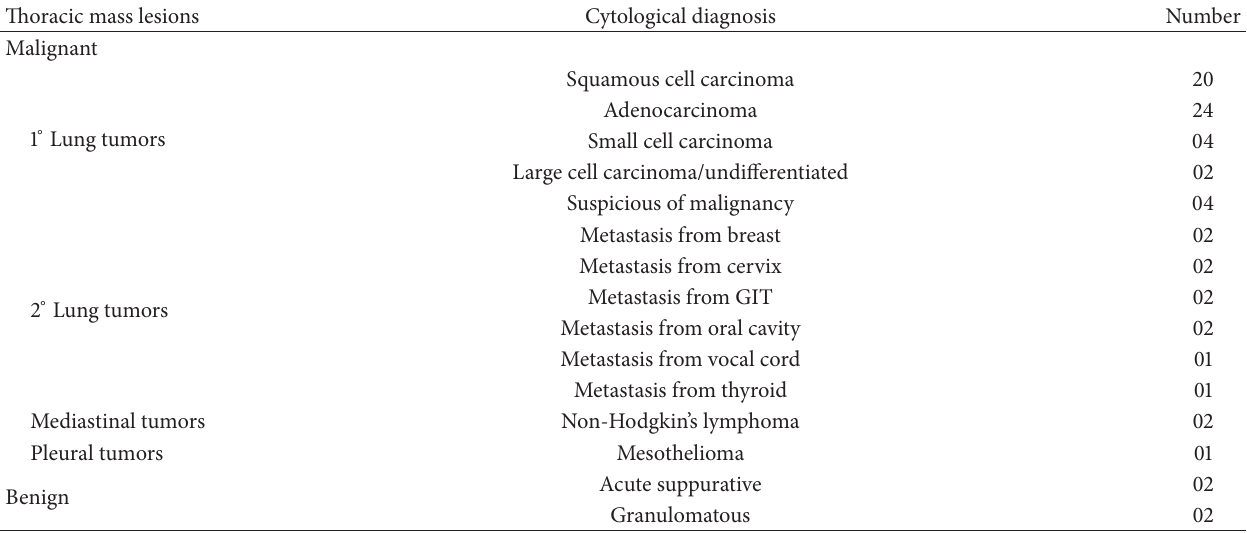
Table 2: Spectrum of lesions in the present study †